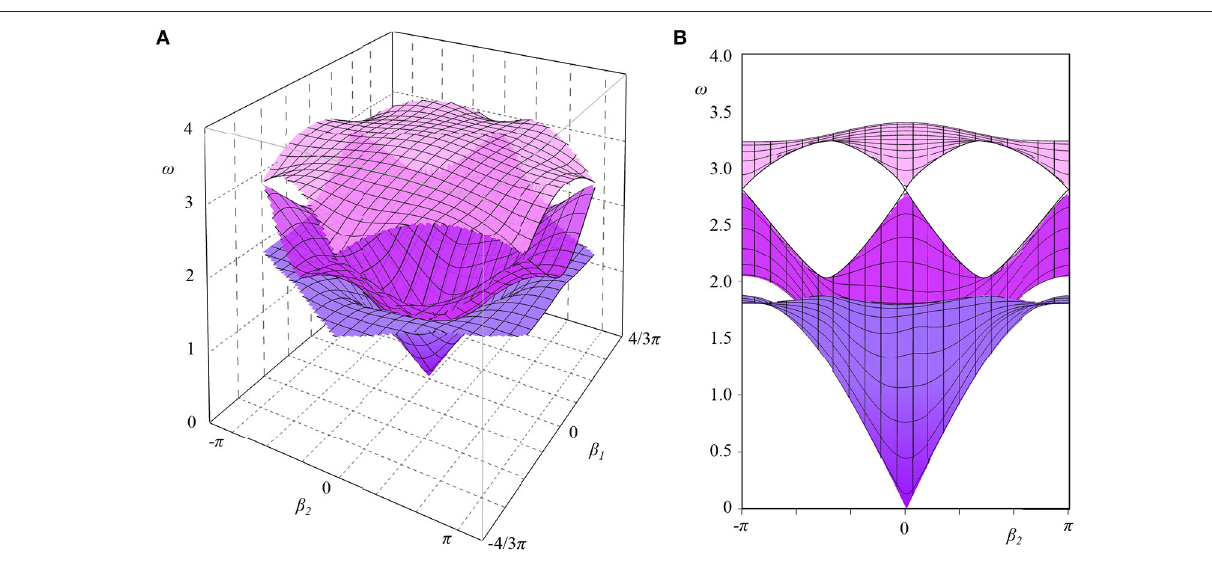
FIGURE 5 | Dispersion spectrum for the optimized beam lattice model of the hexachiral material: (A) 3D view and (B) 2D